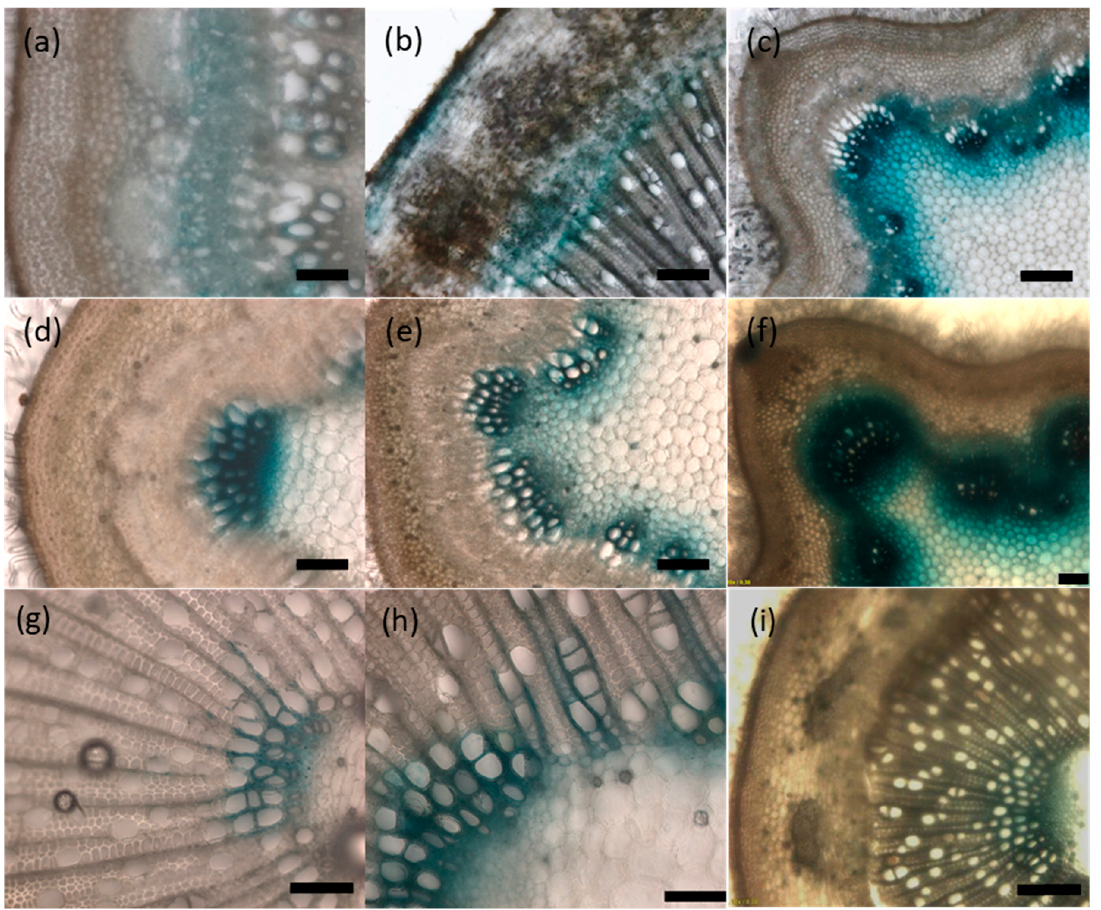
Figure 6. GUS expression patterns in tissues of 4-month-old poplar grown in the greenhouse. ( a ) pUGT72AZ1::GUS expression in the stem 10 cm below the apex. ( b ) pUGT72AZ2::GUS expression in 4 mm diameter root. ( c ) pUGT72A2::GUS expression in stem 5 cm below the apex. ( d ) pUGT72B36::GUS expression in stem 10 cm below the apex. ( e ) pUGT72B37 :: GUS expression in stem 10 cm below the apex. ( f ) pUGT72B39 :: GUS expression in stem 5 cm below the apex. ( g ) pUGT72B36 :: GUS expression in stem 30 cm below the apex. ( h ) pUGT72B37 :: GUS expression in stem 30 cm below the apex. ( i ) pUGT72B39 :: GUS expression in stem 30 cm below the apex. Scale = 100 µm ( a ),( c ),( f ),( i ), 200 µm ( b ),( d ),( e ),( g ),( h ).